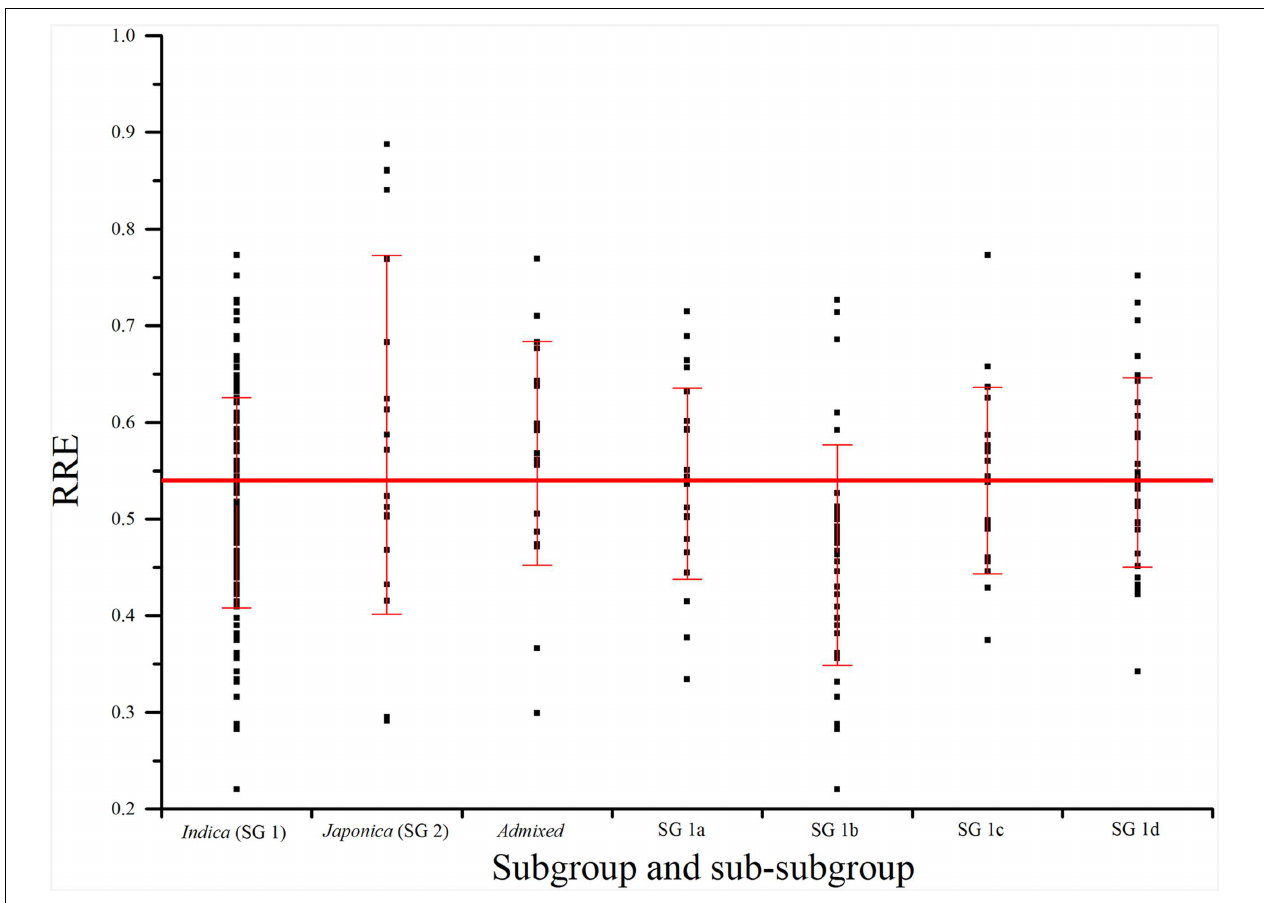
FIGURE 3 | Phenotypic variations (RRE) for aluminum tolerance among subgroups and sub-subgroups. The horizontal line indicates mean of RRE in Ting’s core collection. SG 1, SG 2, SG 1a–d, and admixed were identified in our previous studies using software STRUCTURE (Zhang et al., 2011).